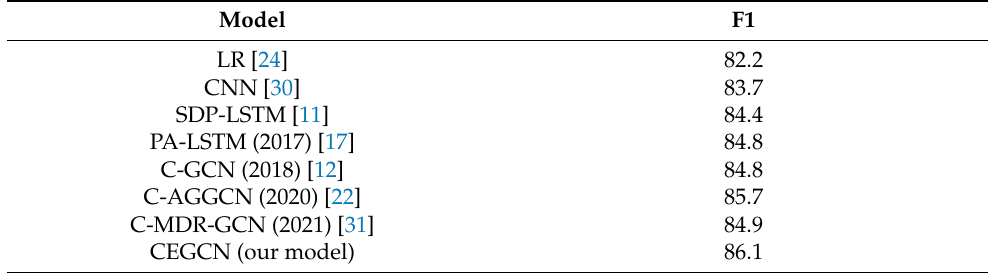
Table 3. Results on the Semeval-2010 Task 8